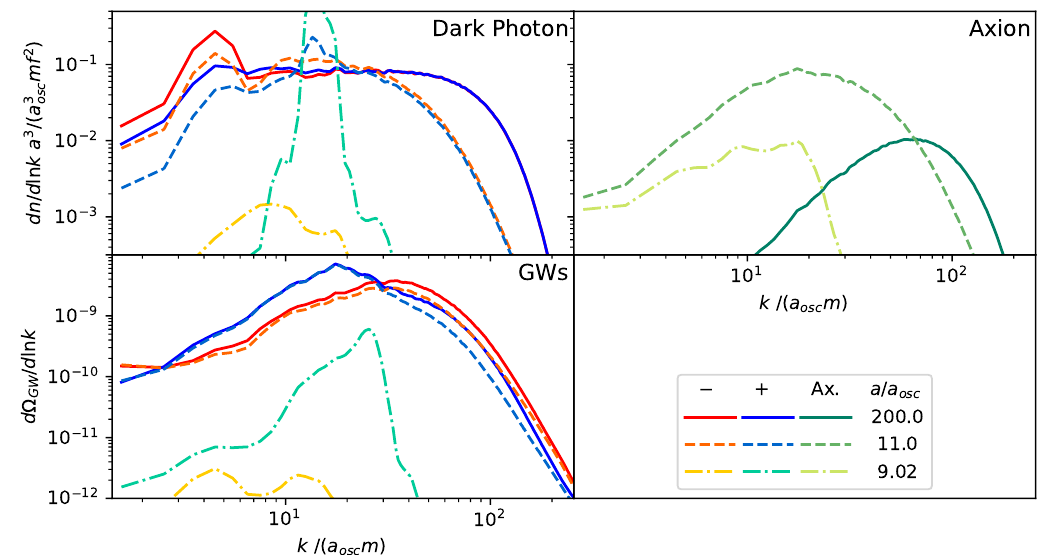
Figure 3: Evolution of the spectra in the non-linear regime. The model parameters are α = 60 and θ = 1. The “ + " polarization is the first to experience tachyonic instability. The dark photon and axion panels correspond to those in Fig. 2 but within a much smaller range of energy